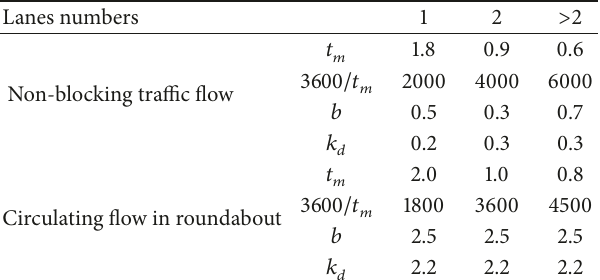
Table 1: Parameter estimation of free flow ratio.